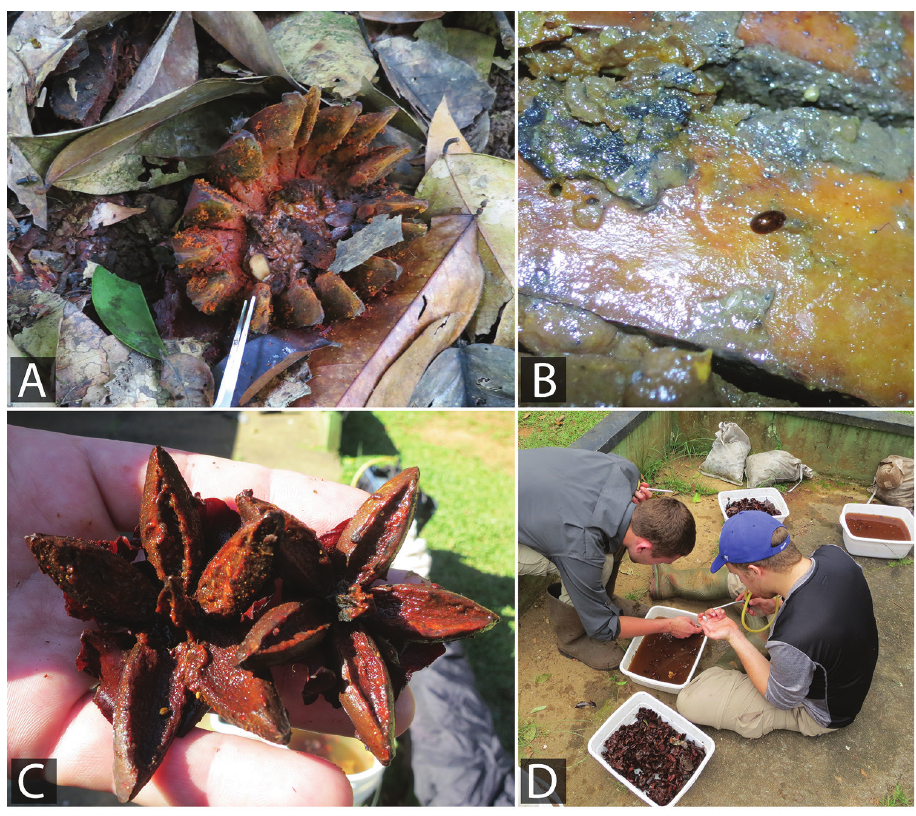
Figure 10. Habitat of Quadriops clusia sp. n.: A Clusia cf. grandiflora on the forest floor, collecting event GY14-0312-04A B A specimen of Quadriops clusia sp. n. crawling on the surface of a rotting Clusia fruit, collecting event GY14-0312-04A C Clusia cf. nemorosa in Brownsberg Nature Park, Suriname on which Quadriops clusia sp. n. was collected D Collecting Quadriops and other terrestrial hydrophilid specimens by submerging collected rotting Clusia fruits in pans of water and waiting for the beetles to float to the surface, collecting event